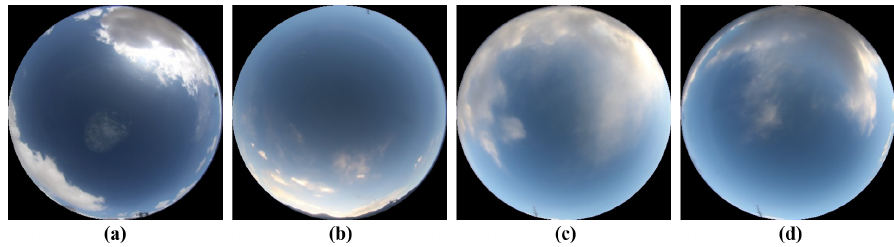
Figure 8. Some misclassified ASC images. (a) Outer to inner, (b) outer to clear, (c) inner to covered and (d) inner to